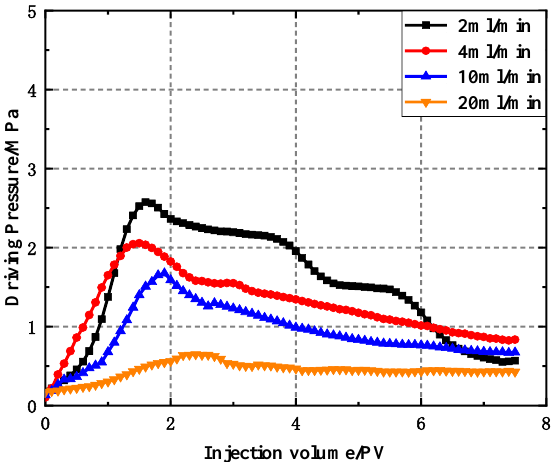
Figure 13. Relationship between the gas injection rate and injection amount during gas injection.